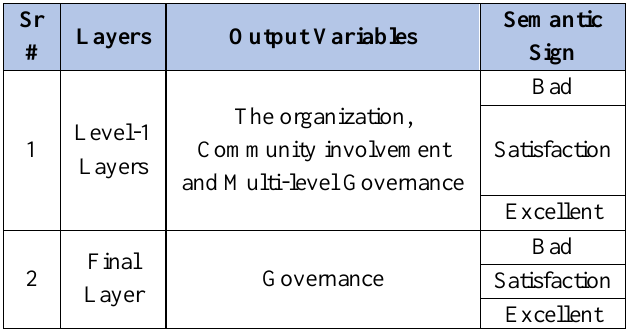
Table 2 . output variable of proposed OGF-SSCT-HMT-1- FES